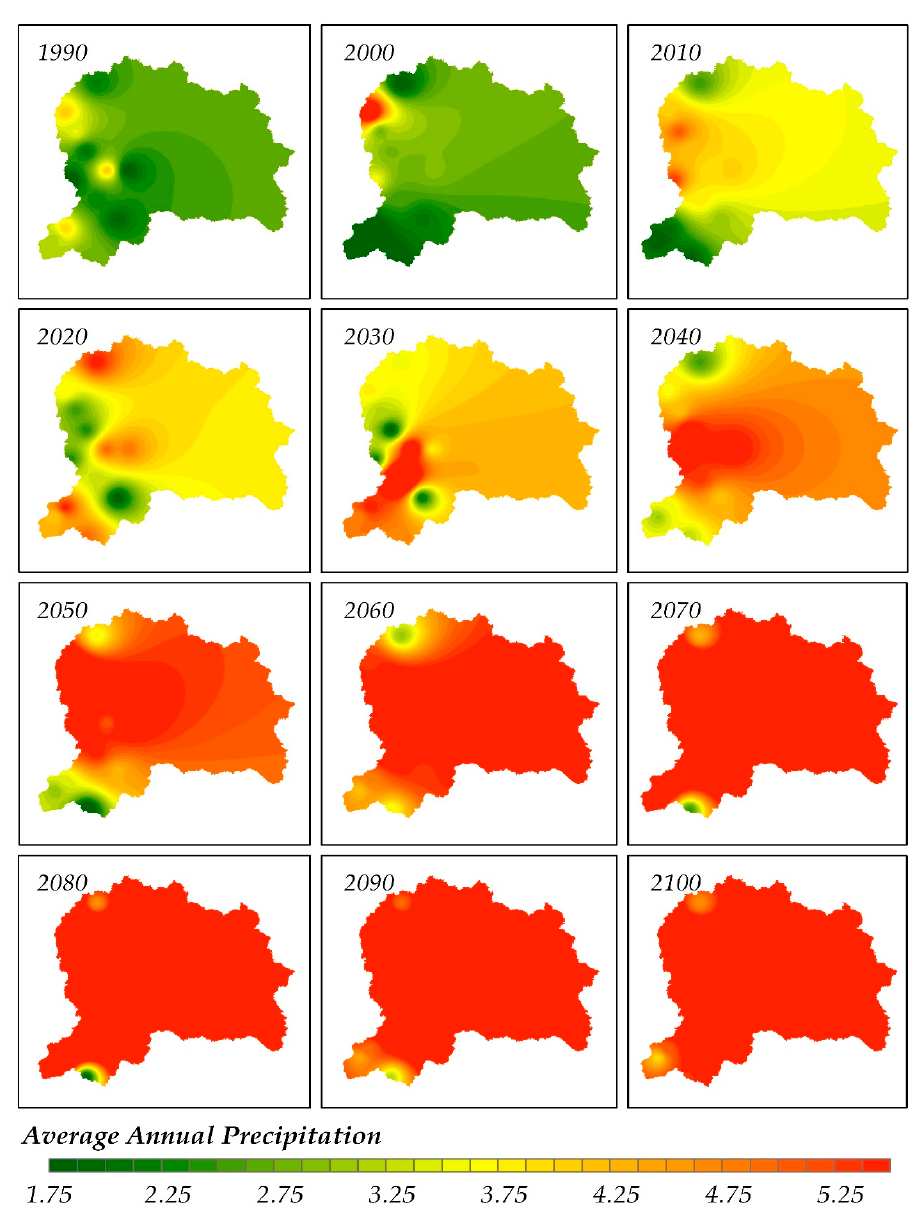
Figure 8. The projected change in average annual rainfall (mm) from 1990 to 2100.